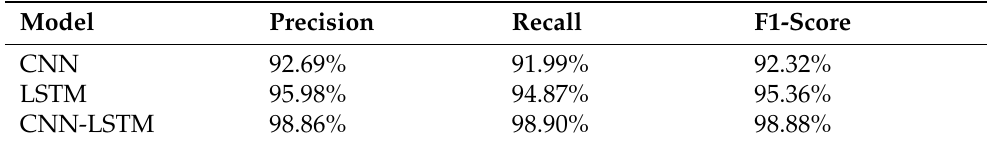
Table 7. Fault detection accuracies of the